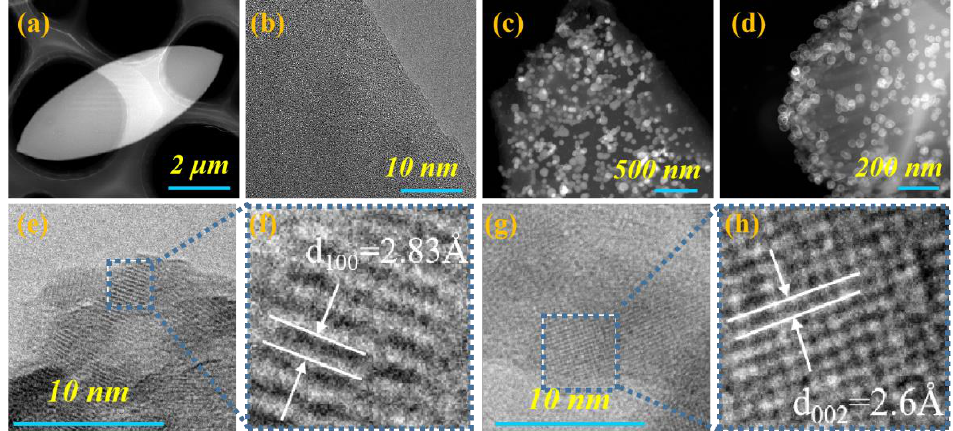
Figure 3. TEM image of the ( a , b ) ZIF-L, ( c ) ZIF-L after resistance to Bacillus subtilis , ( d ) ZIF-L after resistance to Escherichia coli ( e , f ) lattice stripes of ZIF-L after resistance to Bacillus subtilis , ( g , h ) lattice stripes of ZIF-L after resistance to Escherichia coli .